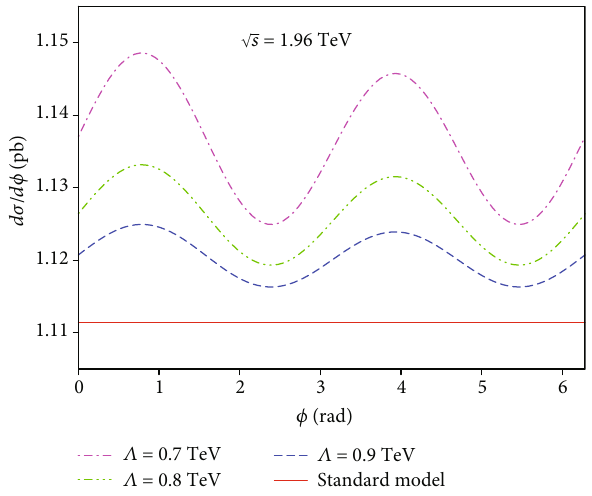
ffiffi p = 1 : 96 TeV s